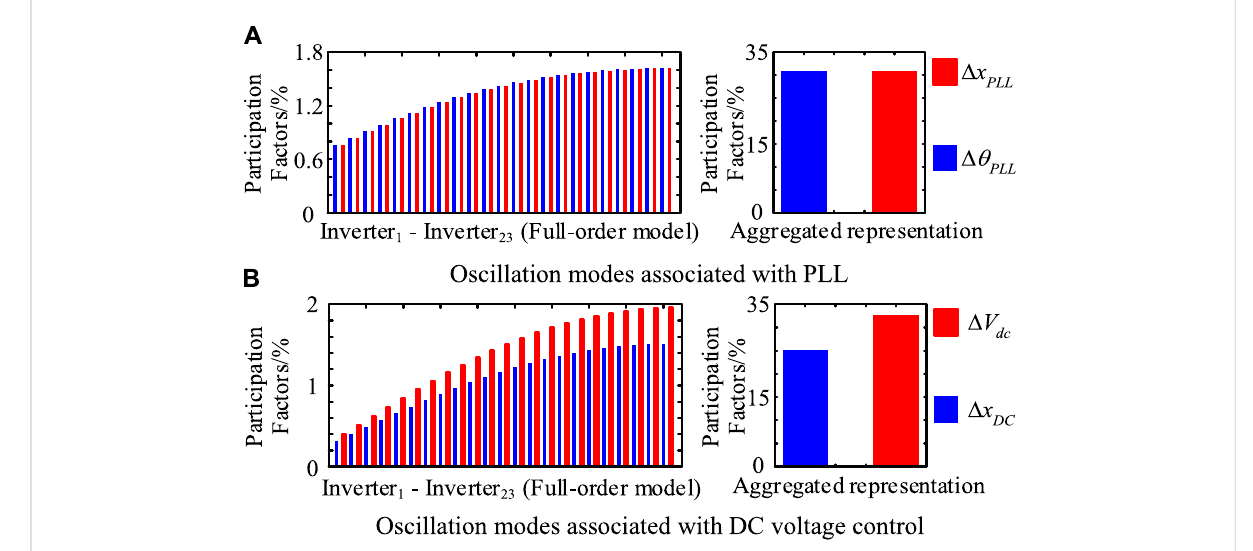
FIGURE 7 Computationalresultsofparticipationfactors(casestudy2,M=23). (A) OscillationmodesassociatedwithPLL. (B) Oscillationmodesassociated with DC voltage control.